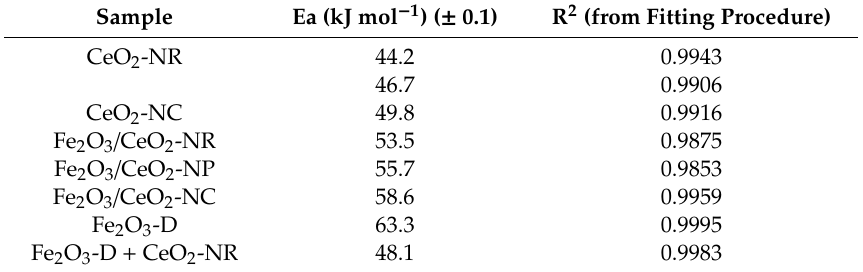
Figure 8. Arrhenius plots for CO conversion as a function of temperature for Ceria and Fe 2 O 3 / Ceria samples of different morphology (NR, NC, and NP, as indicated). Reaction conditions: 2000 ppm CO, 1 vol.% O 2 , GHSV = 40,000 h − 1 . Table 4. Activation Energies (E a ) for the CO oxidation reaction over bare CeO 2 and Fe 2 O 3 / CeO 2 samples.